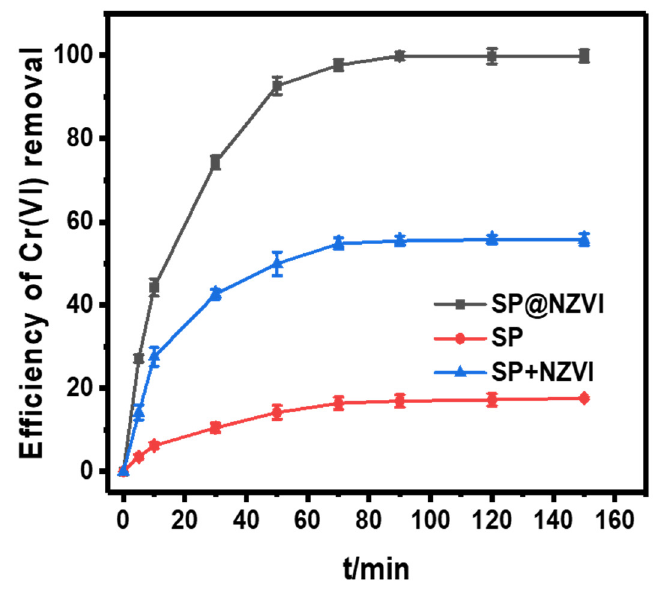
Figure 6. The effect of different materials on Cr(VI) removal. Table 4. Comparison of adsorption capacities of Cr(VI) ions on SP and SP@nZVI with reported adsorbents.